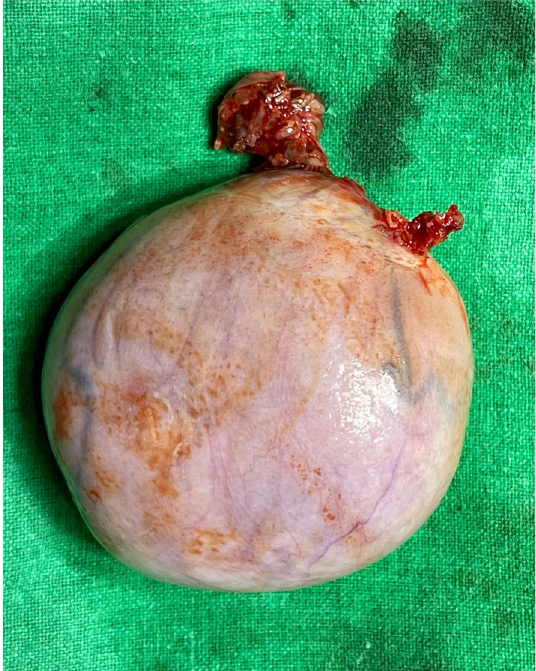
Fig. 1 Photograph of the ovarian mass after